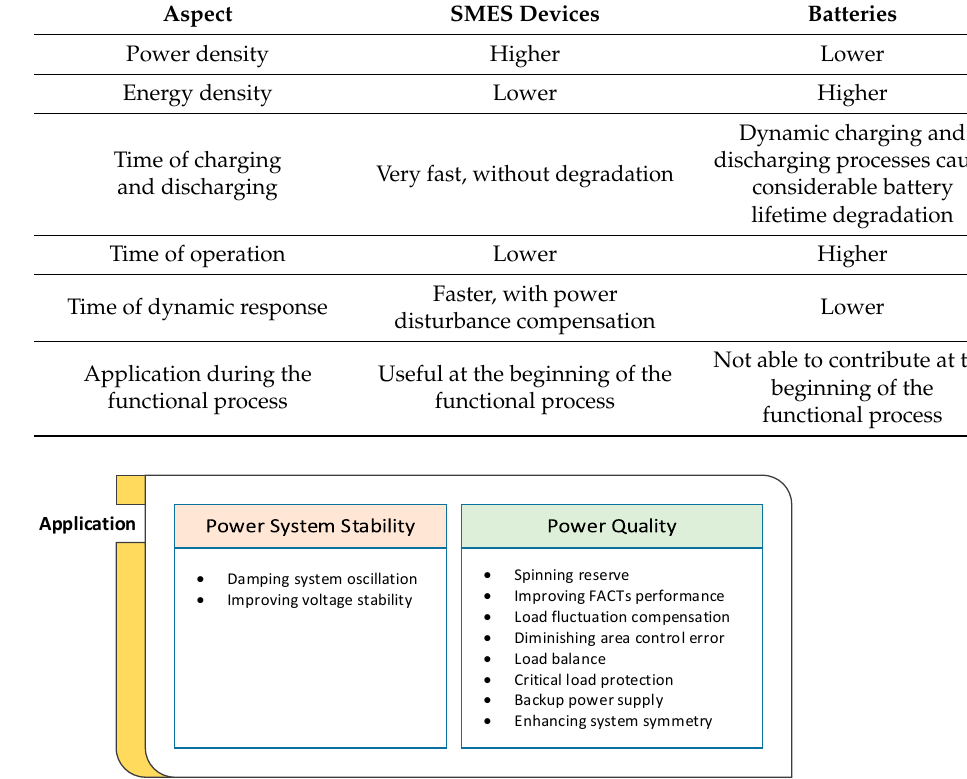
Figure 7. Examples of SMES applications.